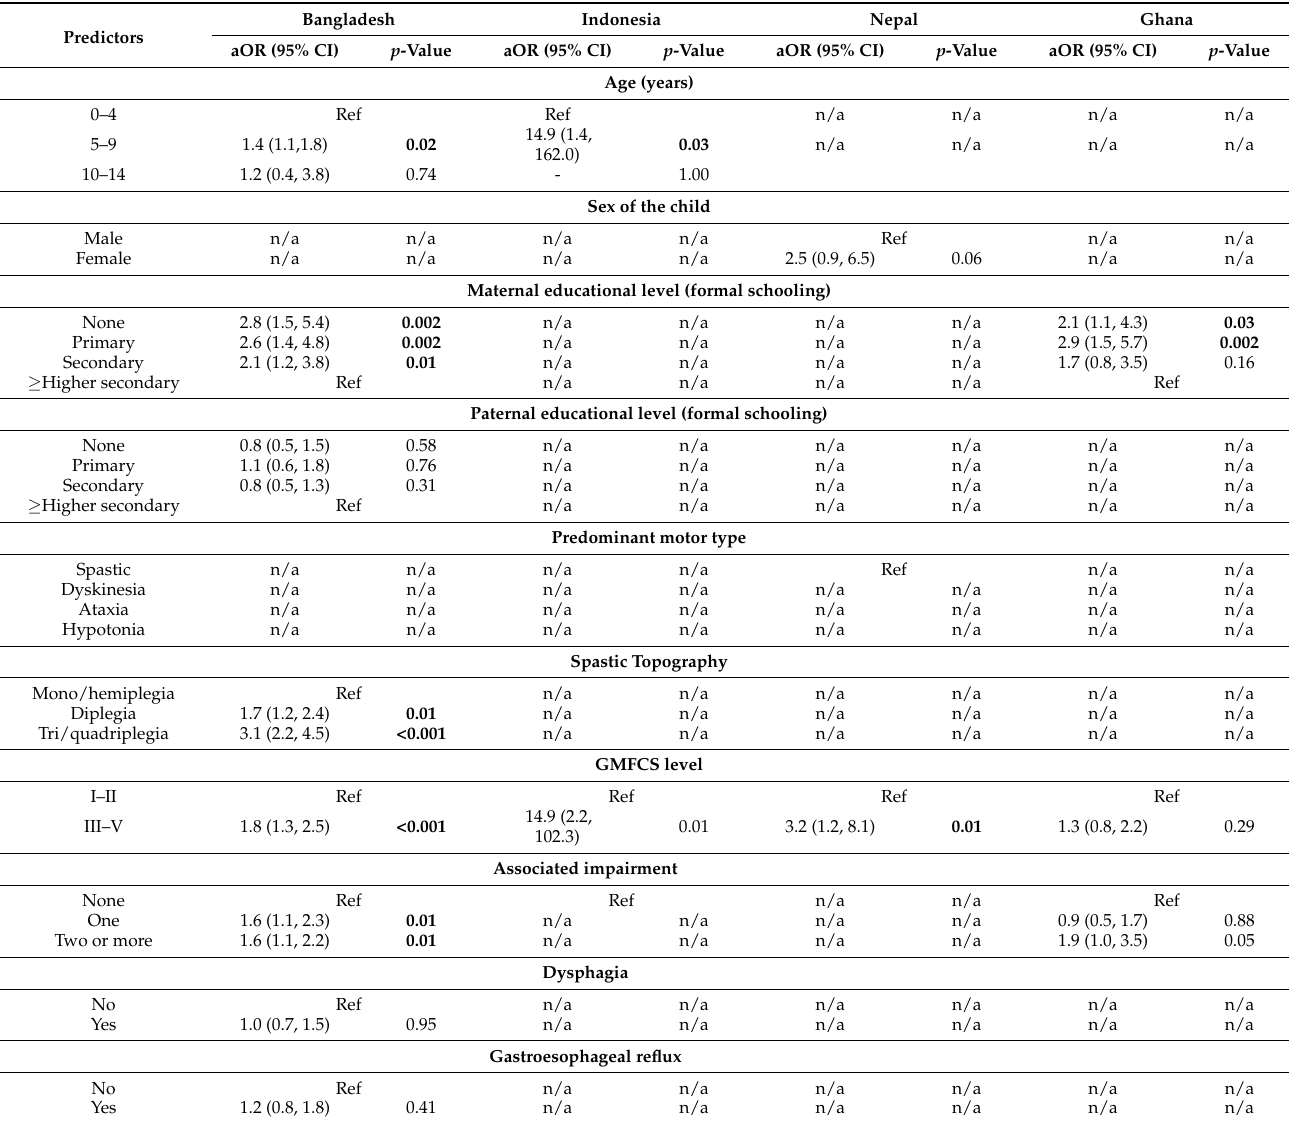
Table 4. Predictors of underweight (WAZ < − 2SD) among children with CP registered in GLM CPR (adjusted odds